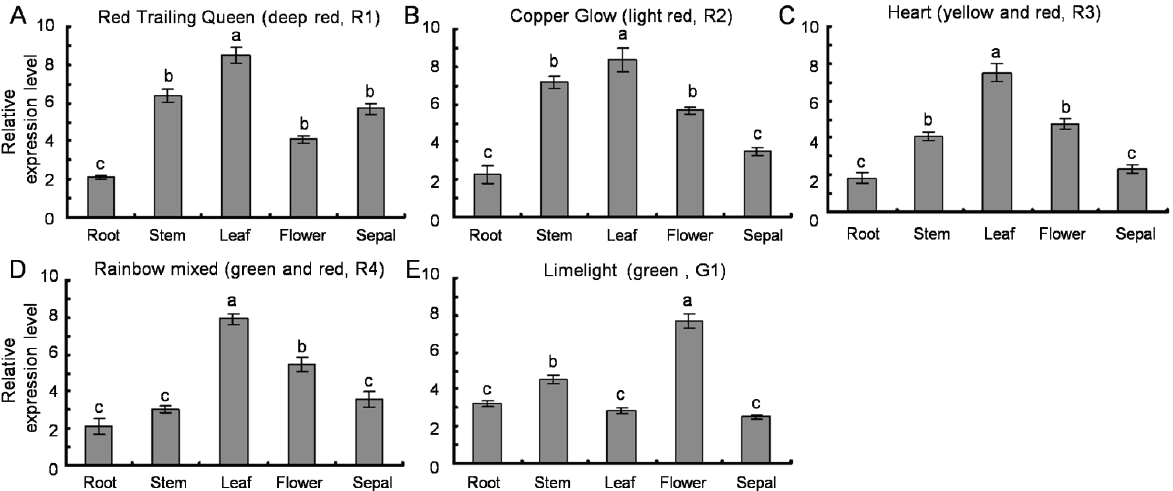
Figure 6. Expression pattern of SsPAL1 in different tissues of five Coleus cultivars by qRT-PCR analysis ( A – E ). The qRT-PCR results were calculated as differences in cycle threshold (Ct) between the SsPAL and SsACT gene (2 −∆ Ct ). All reactions were carried out in triplicate, and each experiment was repeated twice. The same lowercase letter is not significantly different ( p >